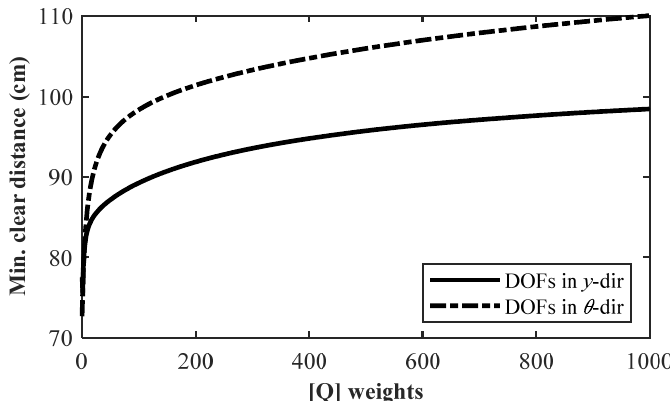
Figure 17. Minimum Clear distance required to avoid pounding using active control with respect to different response weights.